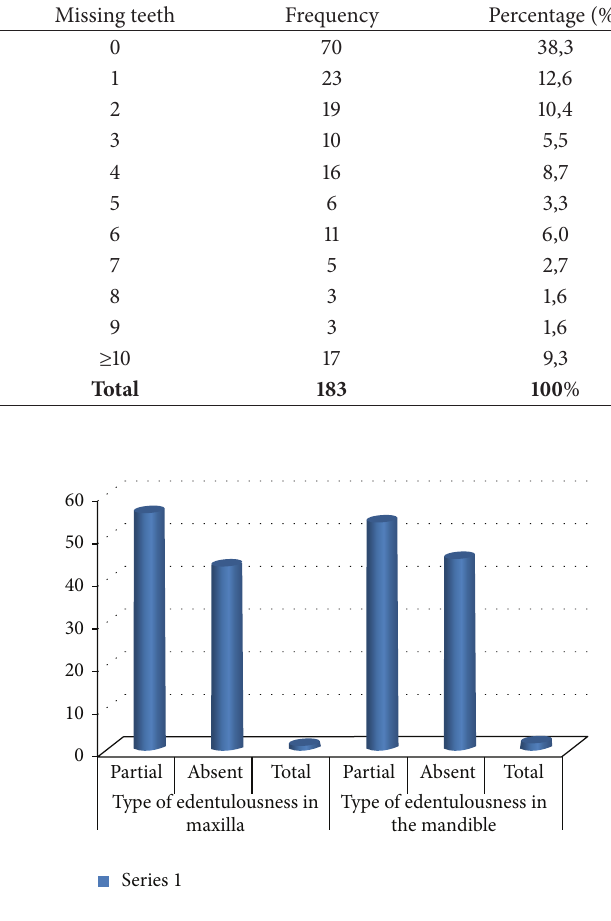
Figure 5: Distribution of the study population according to the type of